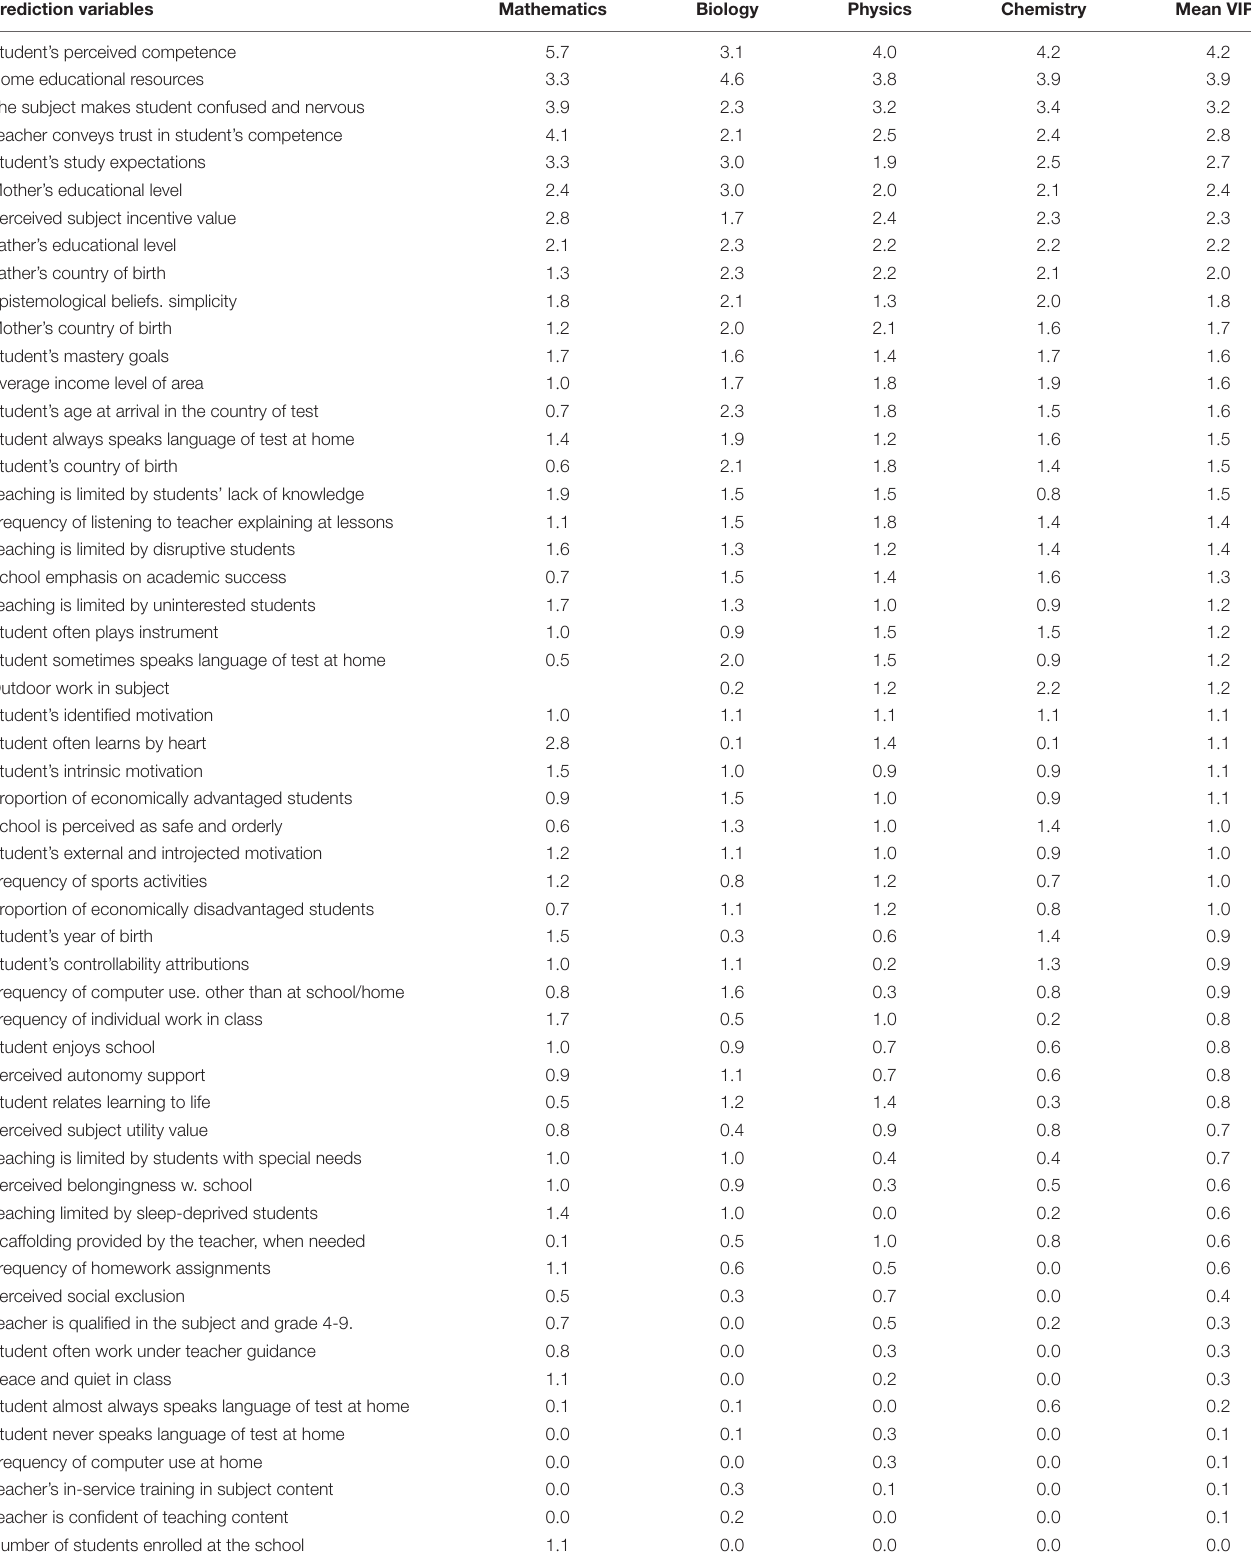
TABLE 3 | VIP values for the top variables (VIP > 1) for predicting PVs in each